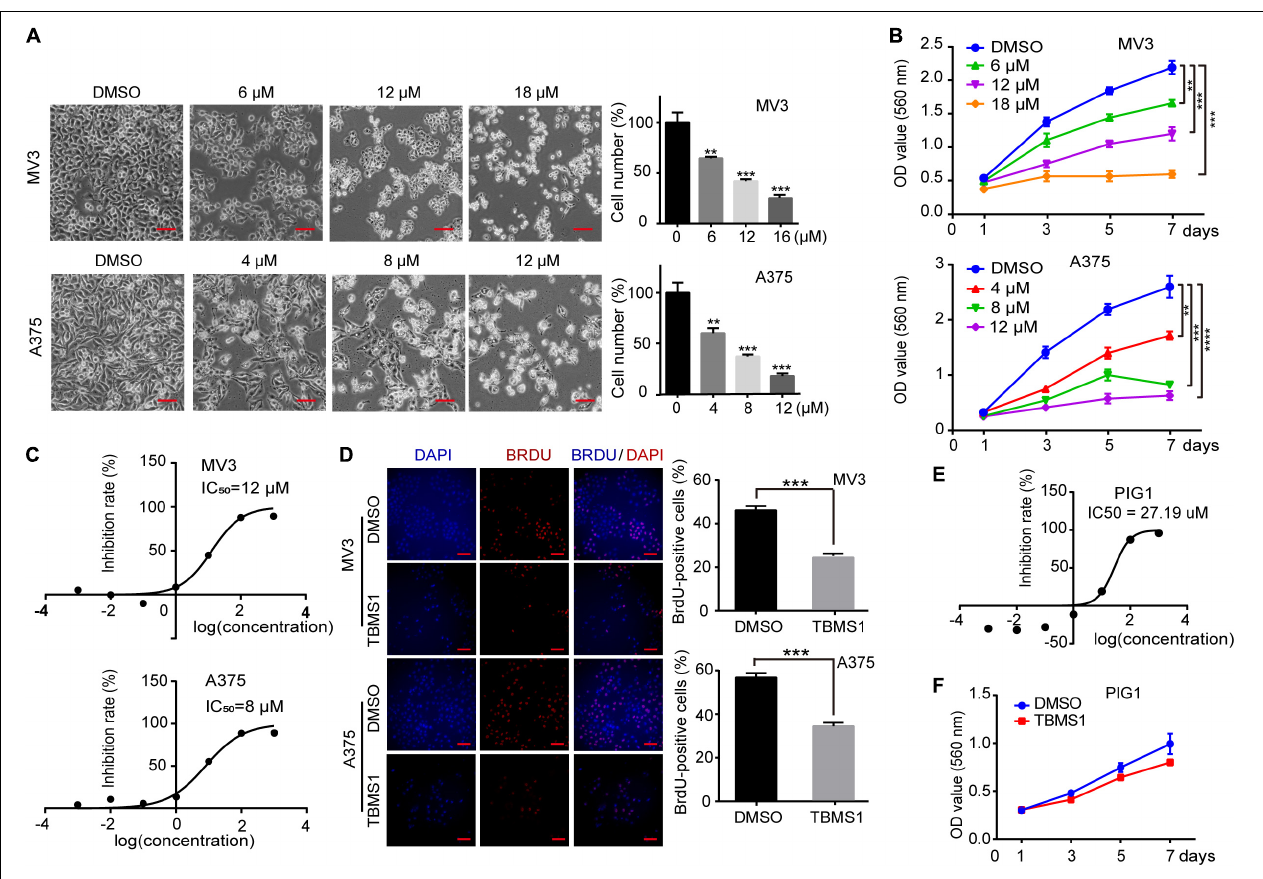
FIGURE 1 | TBMS1 inhibits cell proliferation in melanoma cells in vitro . (A) Cell morphology of MV3 and A375 melanoma cells after treated with DMSO or TBMS1 in different concentration for 48 h. Cell numbers of MV3 and A375 cells were counted under microscope and then analyzed. Cell numbers of DMSO-treated group were regarded as 100%. (B) Viability of MV3 and A375 cells after treated with DMSO or TBMS1. (C) IC 50 of TBMS1 in inhibition of cell proliferation in MV3 and A375 cells. (D) BrdU-positive MV3 and A375 cells after treated with DMSO or TBMS1 for 48 h. Quantifications of BrdU-positive MV3 and A375 cells were calculated. (E) IC 50 of TBMS1 in inhibition of cell proliferation in PIG1 cells. (F) Viability of PIG1 cells after treated with DMSO or 12 µ M TBMS1. A two-tailed unpaired Student’s t -test was carried out. * p < 0.05, ** p < 0.01, *** p < 0.001, **** p <